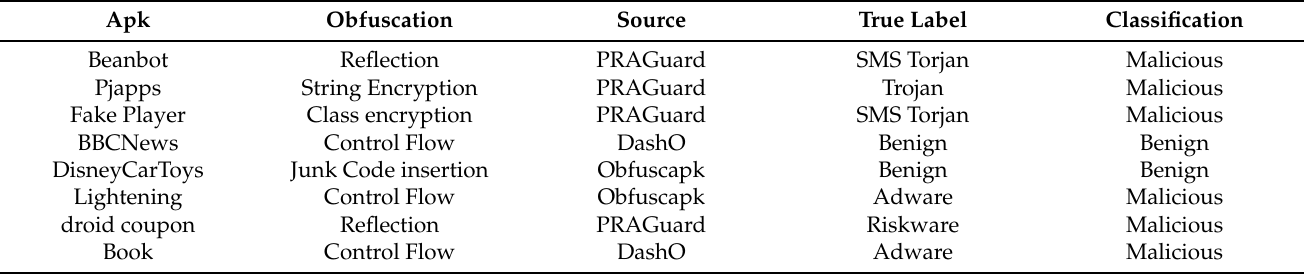
Table 5. Performance for obfuscated malicious and benign